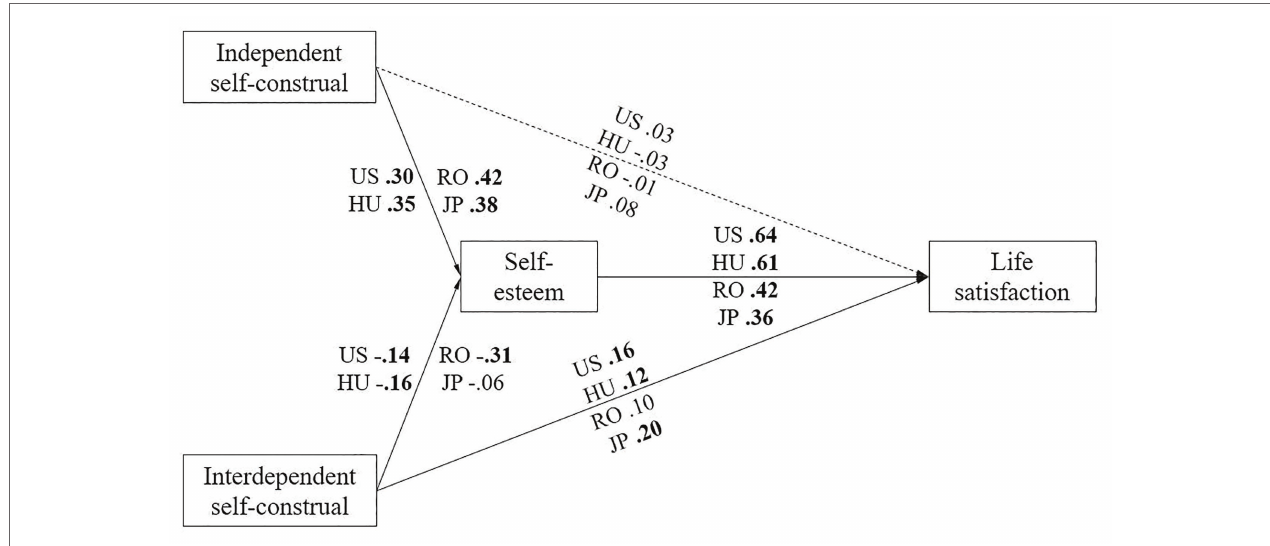
FIGURE 1 | The path model of the relationships between independent and interdependent self-construal, self-esteem, and life satisfaction in all four cultures. In this figure, the values shown are standardized path coefficients; the statistically significant coefficients are shown in bold. Continuous lines represent significant paths in at least one sample ( p < 0.05), whereas the interrupted line represents non-significant path ( p > 0.05). US, United States sample; HU, Hungarian sample; RO, Romanian sample; JP, Japanese sample.